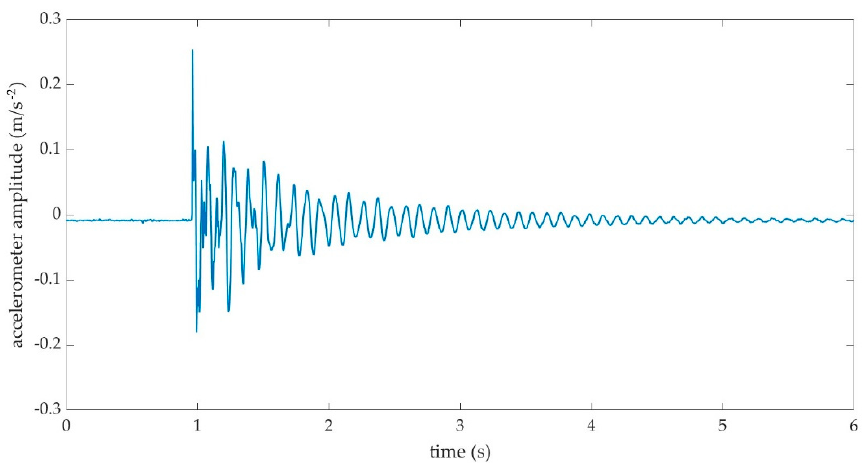
Figure 1. Accelerometer y-axis normalized impulse excitation.